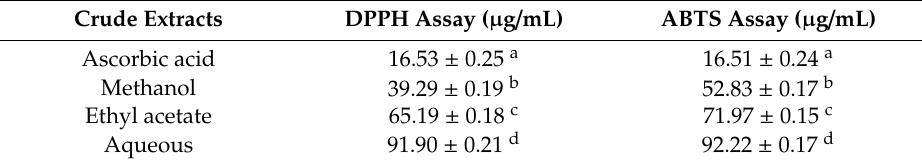
Statistical significance was determined at p < 0.05 and is indicated with di ff erent letters.